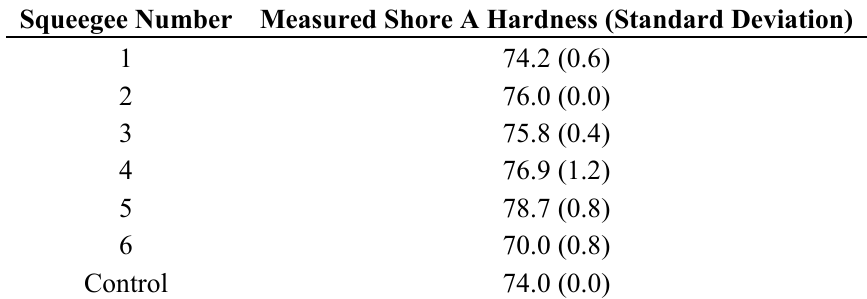
Table 1. Squeegees used in the